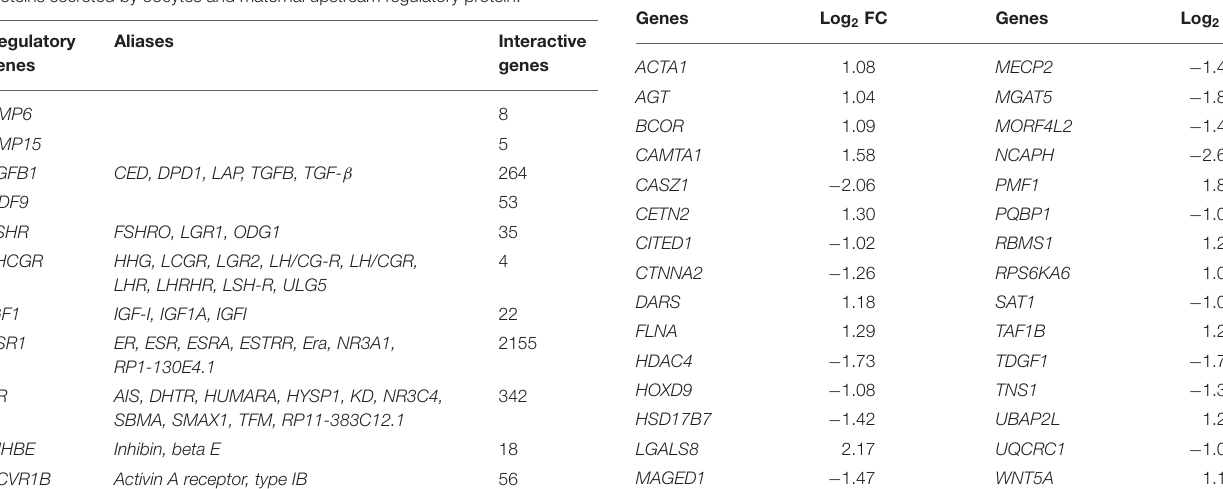
TABLE 2 | Overlapping genes between BioGRID and genes